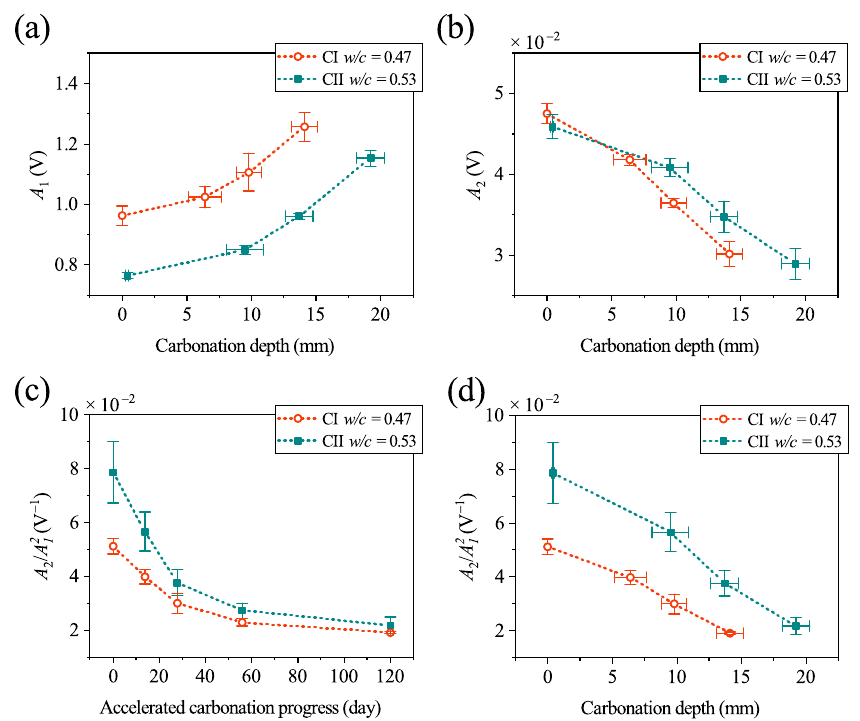
Figure 9. Fundamental amplitudes, harmonic amplitudes and non-linear parameters of CI ( w / c = 0.47 ) and CII ( w / c = 0.53 ) . Table 3. The average non-linear parameters with carbonation